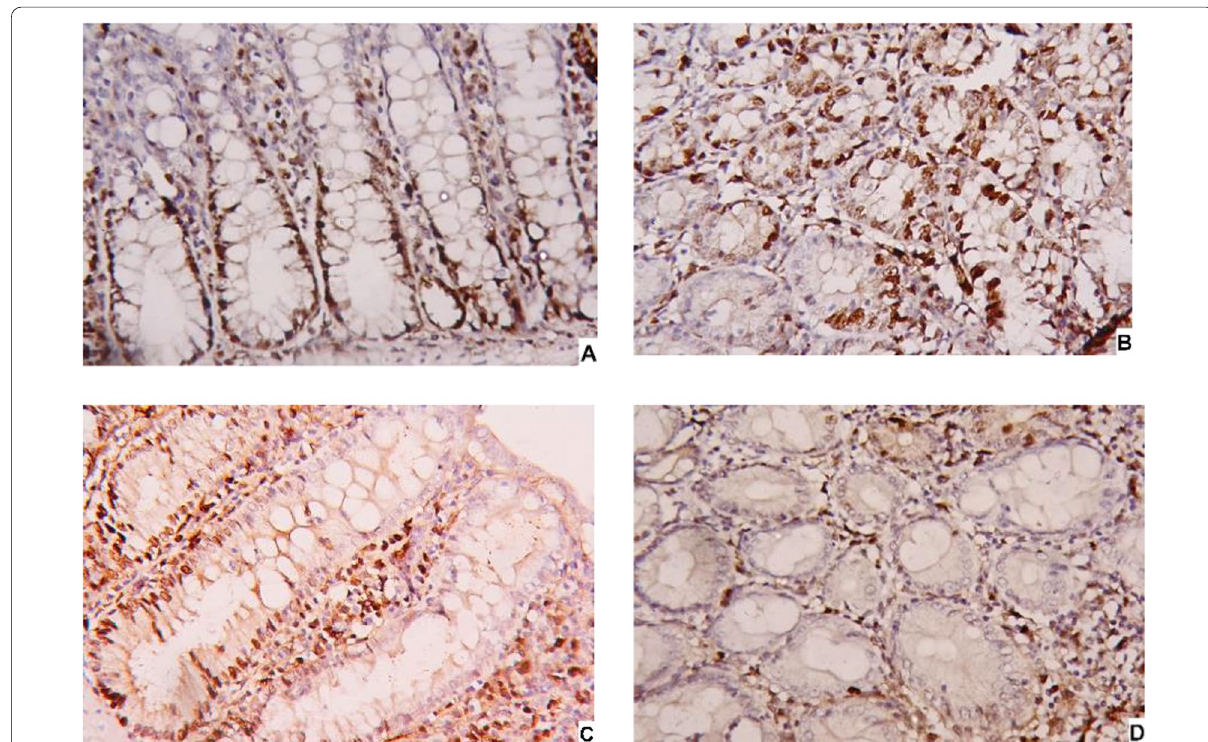
Fig. 5 Photomicrographs of colon sections of different groups immune-stained with Ki67 ( Ki67 expression. B : DMH group showed severe Ki67 immunoreactivity. C : 5FU group showed moderate Ki67 expression in mucosal glands. D FA and 5FU combined treated group showed an approximately normal anti-Ki67